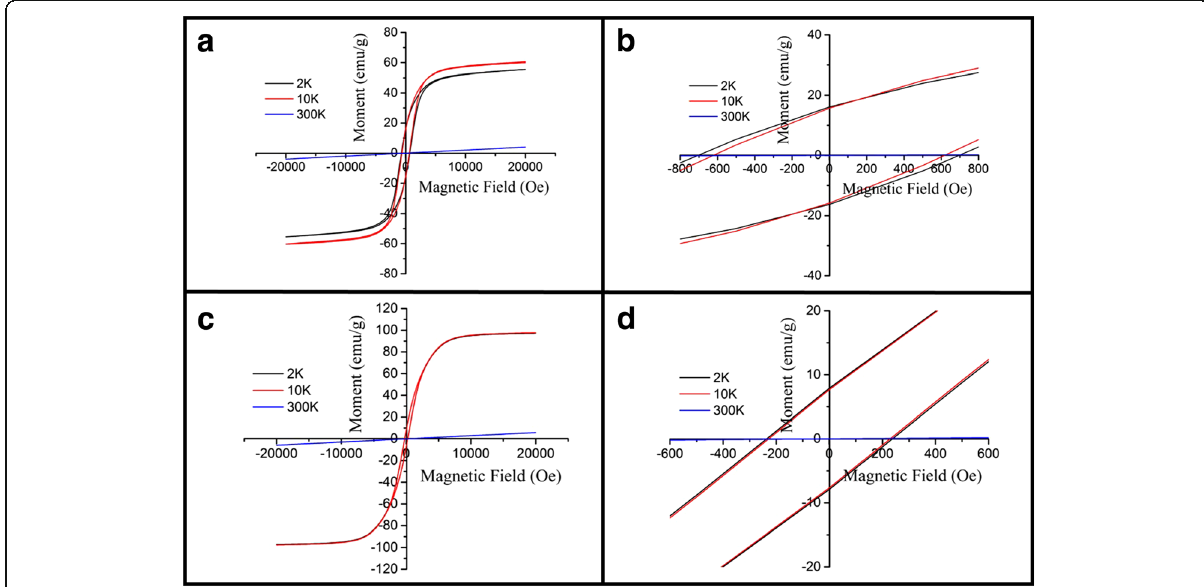
Fig. 10 a and c M – H hysteresis loops of the (La 0.6 Pr 0.4 ) 0.67 Ca 0.33 MnO 3 nanoparticles post-annealed at 800 and 1000 °C, respectively. b and d are the corresponding local enlarged M – H hysteresis loops in ( a and c ), respectively